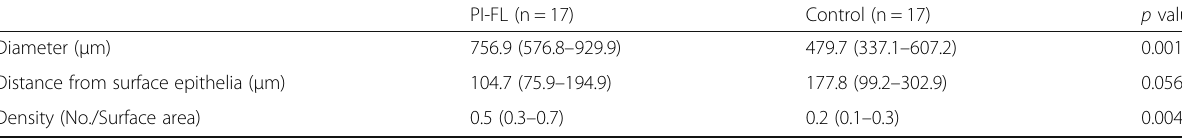
Table 3 Comparisons between neoplastic follicles in PI-FL and control cases with intestinal reactive lymphoid